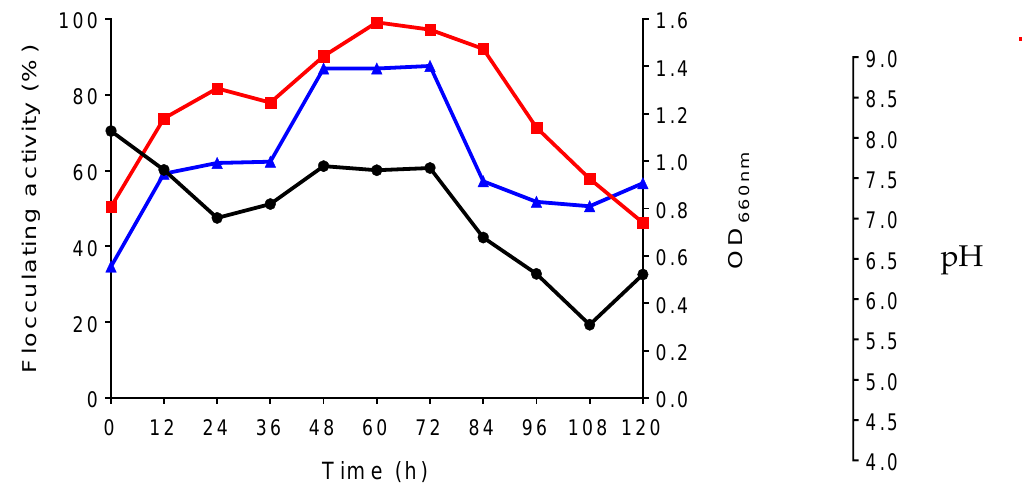
Figure 2. Effect of time course on flocculating activity, fungal growth, and pH.